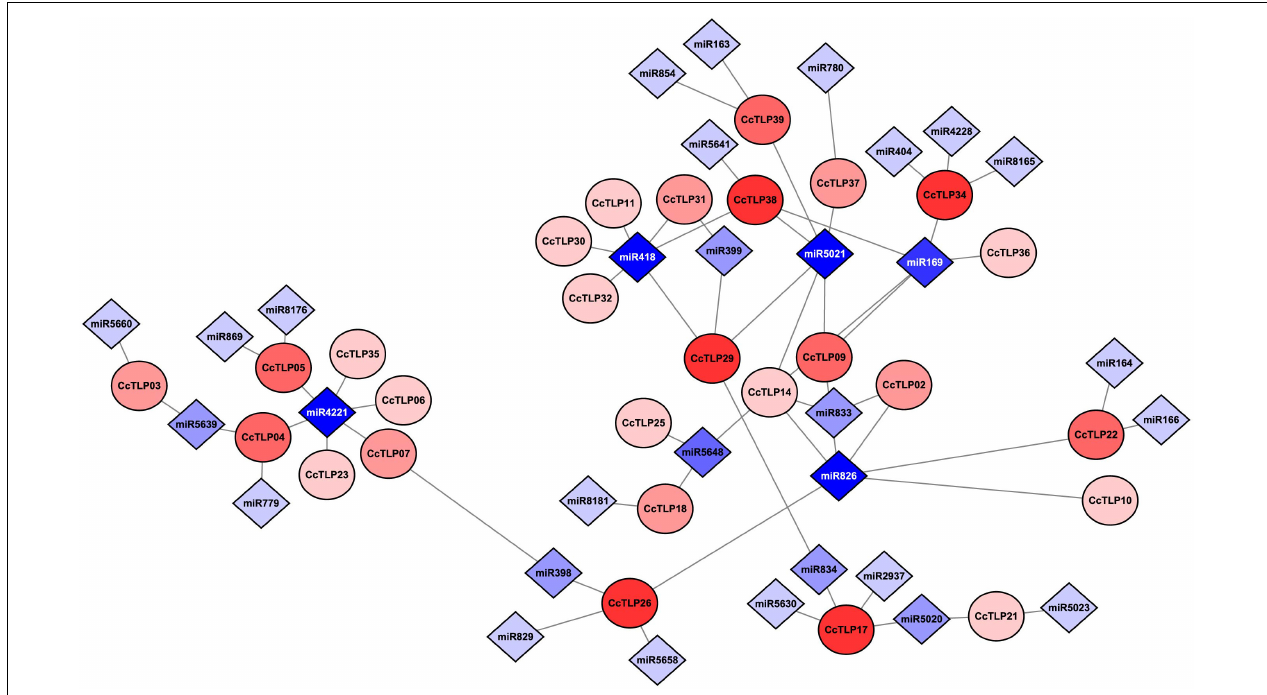
FIGURE 5 | Interaction network diagram between 29 CcTLP genes and 31 micro RNAs (miRNAs). Circle elements represented CcTLP genes and rhombus elements represented miRNA interacting with CcTLP genes. The level of color depth indicated the co-regulation ability.